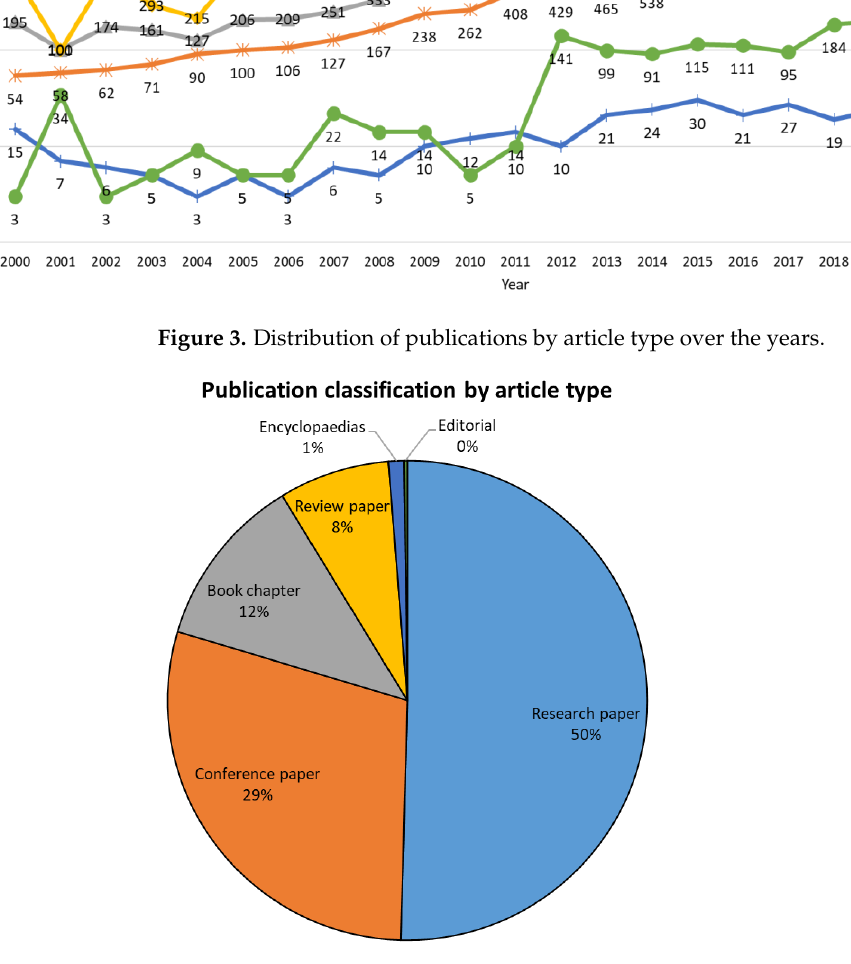
Figure 4. Proportion of publication classification by article